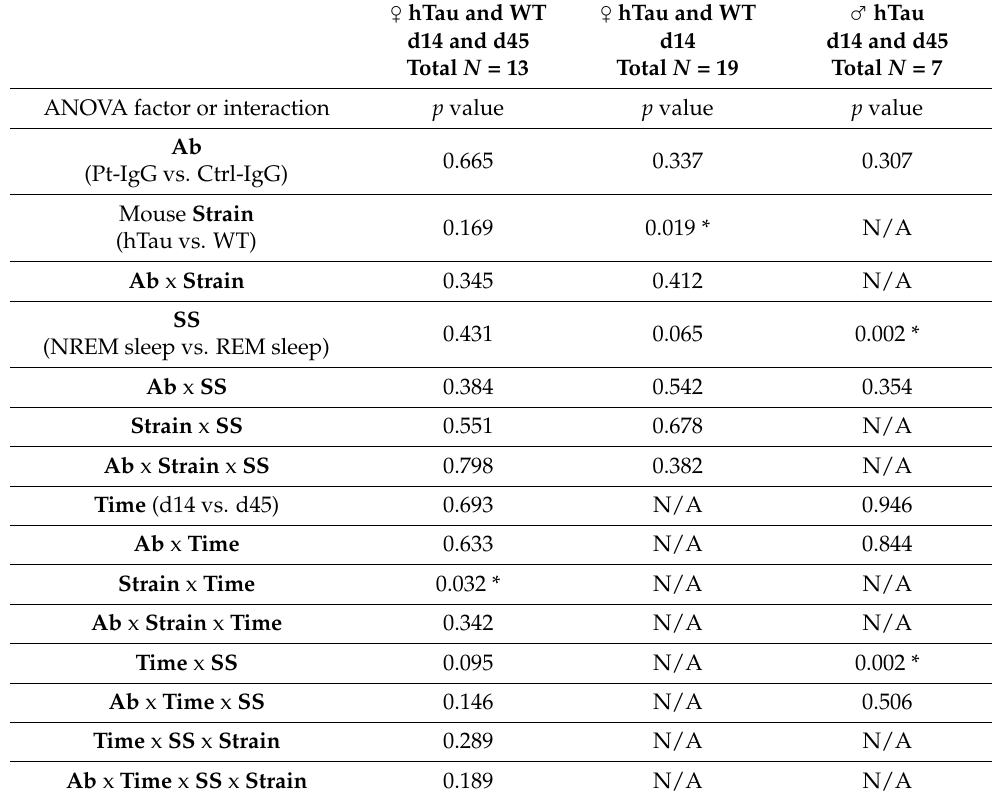
Table A8. Statistical analysis of sleep apnea occurrence rate.